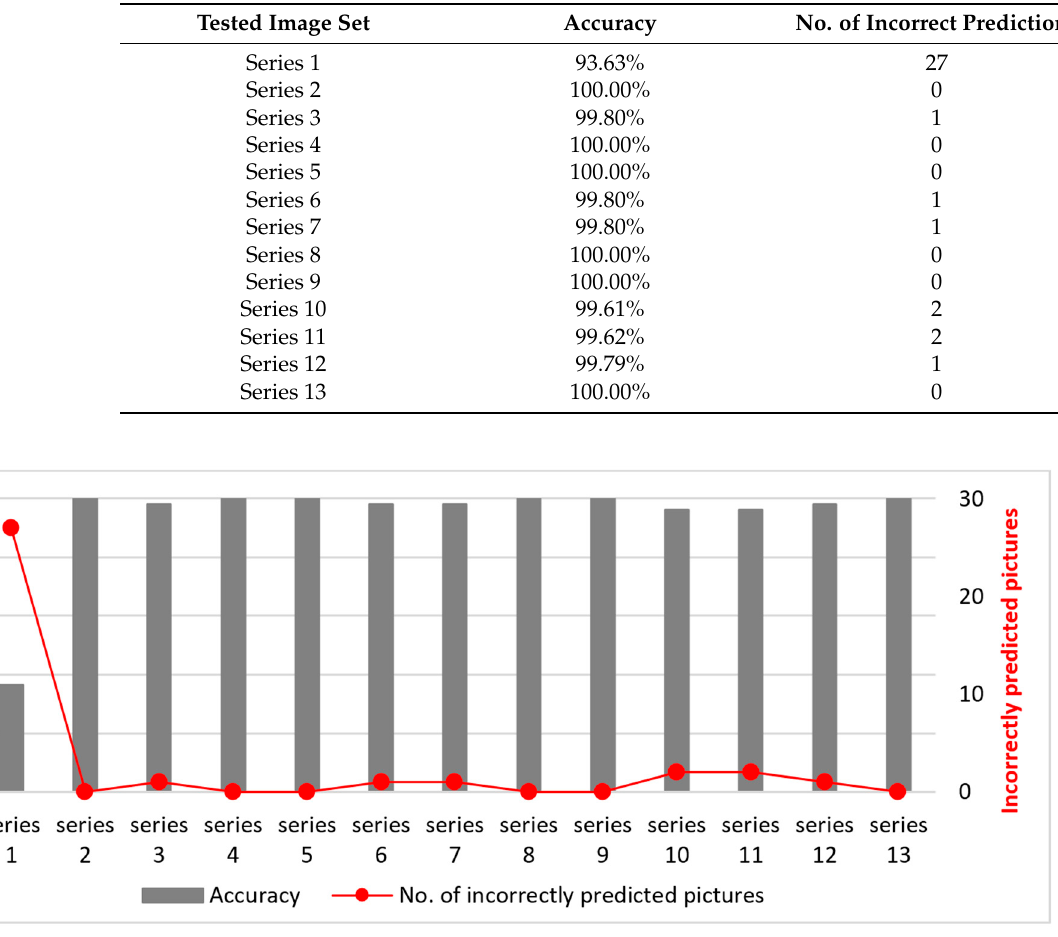
Figure 11. Classification results for different image test sets. Table 12. The classification accuracy for each test set.